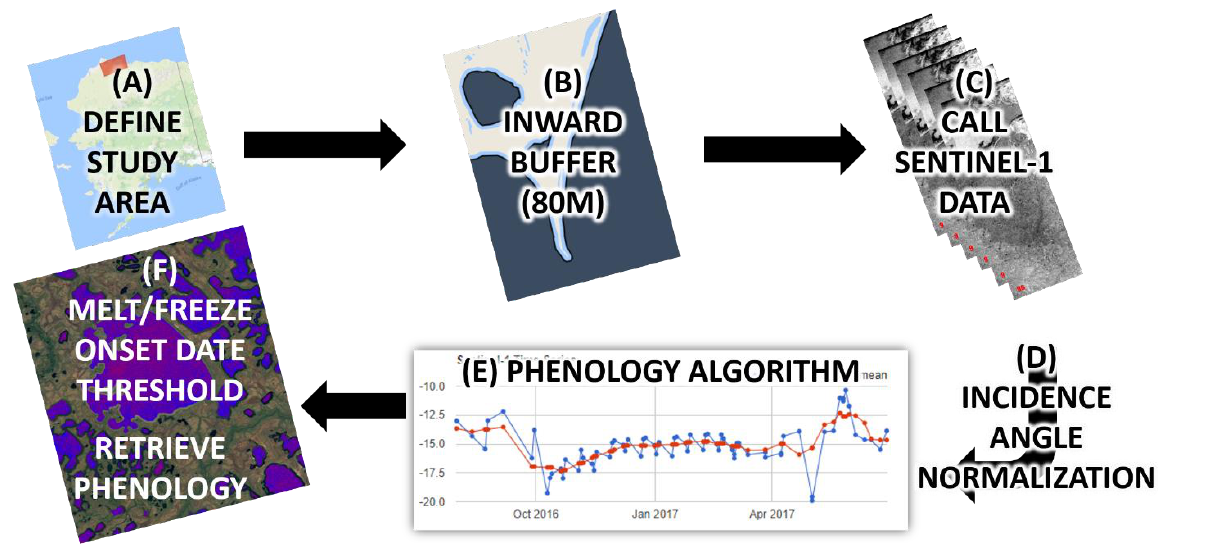
Figure 6. Flowchart of automated ice phenology retrieval using Sentinel-1 acquisitions within the Google Earth Engine coding environment. The steps within the processing chain are as follows: ( A ) a study area is defined using either a user-defined polygon or imported lake boundary. ( B ) An inward buffer of the polygon is generated at a distance of 80 m to avoid mixed pixel effects of backscatter from the lake edge. ( C ) Sentinel-1 acquisitions intersecting the boundary are called from the Sentinel-1 GRD GEE repository, where ( D ) an incidence angle normalization is applied as described by [60,61], and ( E ) a smooth algorithm is applied to the winter-time series of Sentinel-1 backscatter on a per pixel basis. ( F ) Once a drop in the smoothed backscatter is detected that exceeds a user-defined threshold, the date of the drop is recorded and flagged as freeze-onset, or